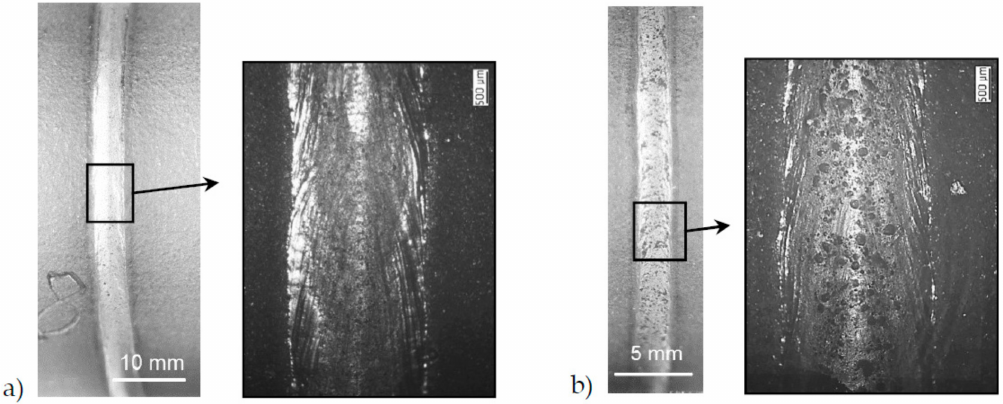
Figure 4. WeldedsamplesofIN718withdifferentedgequality: ( a )withmachinededge,and( b